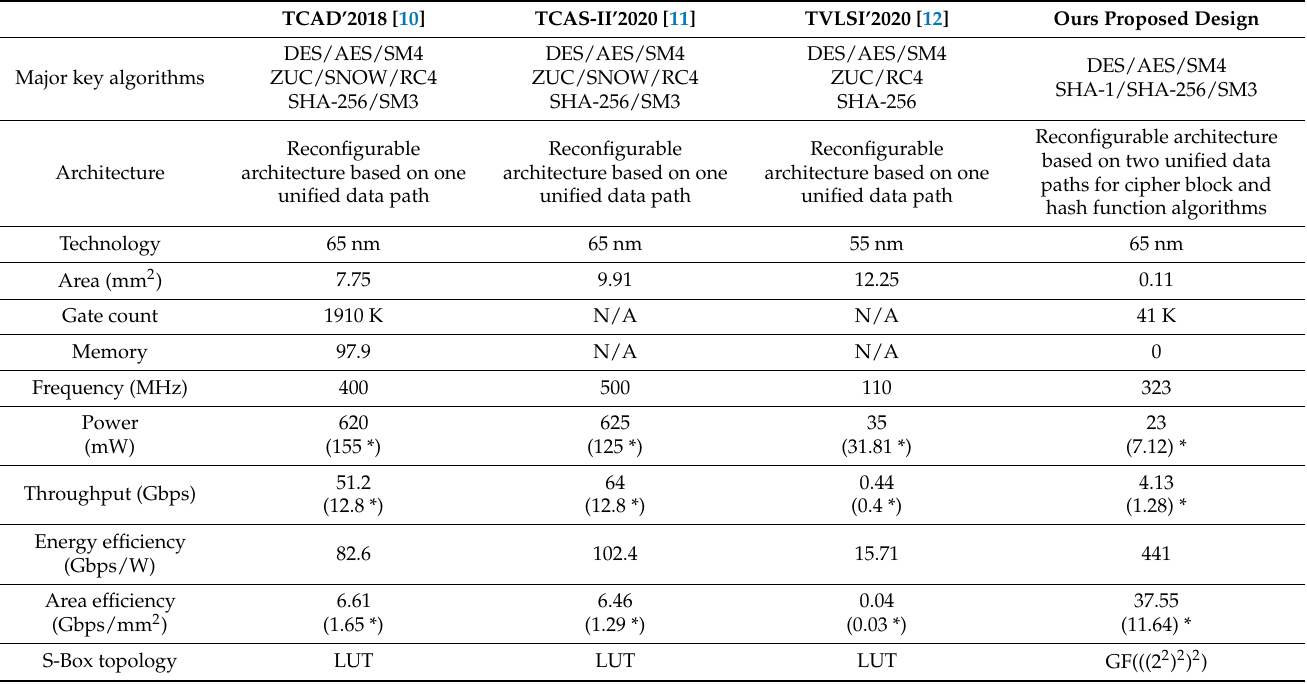
Table 9. Overall comparison of the proposed reconfigurable cryptographic accelerator and existing designs based on ASIC